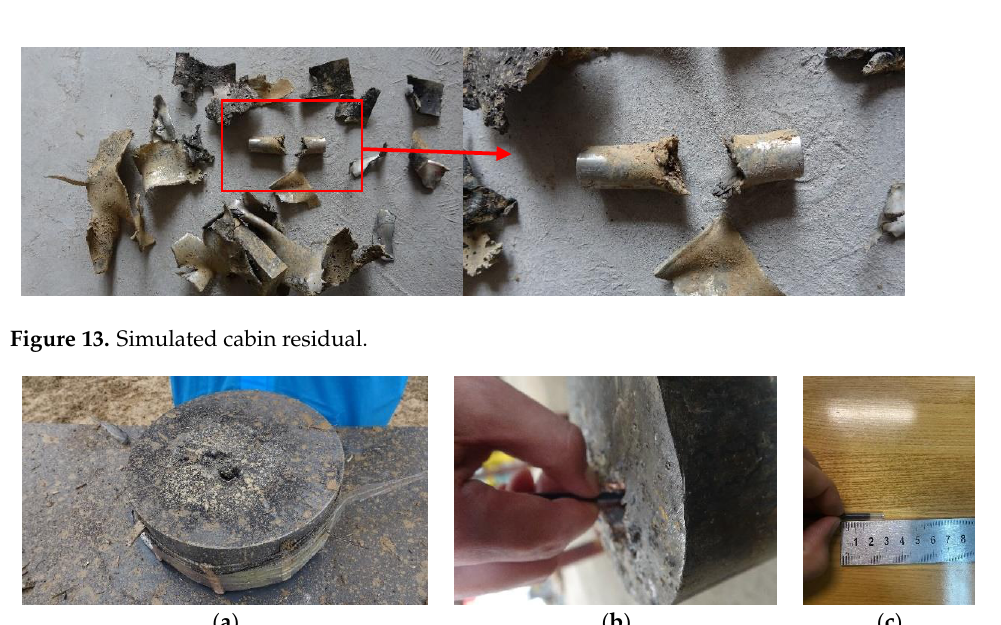
Figure 14. Penetration result of the Q235 steel target with the simulation cabin: ( a ) steel target after penetration, ( b ) jet depth measurement diagram, and ( c ) jet length.